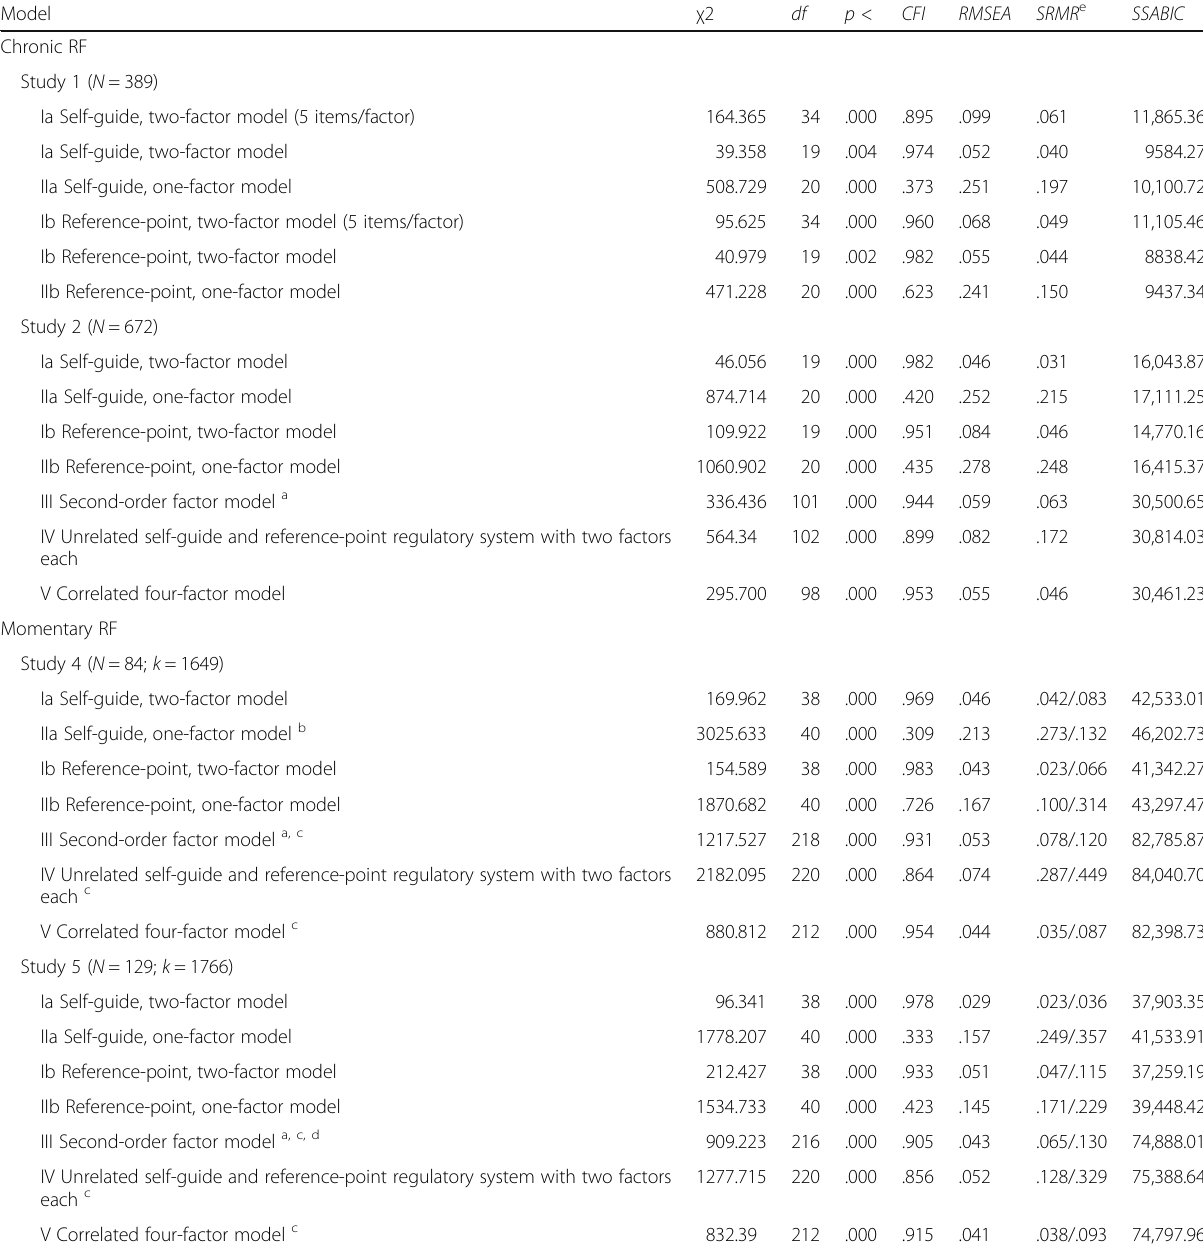
Table 1 Confirmatory factor analysis of the Momentary – Chronic RF scales